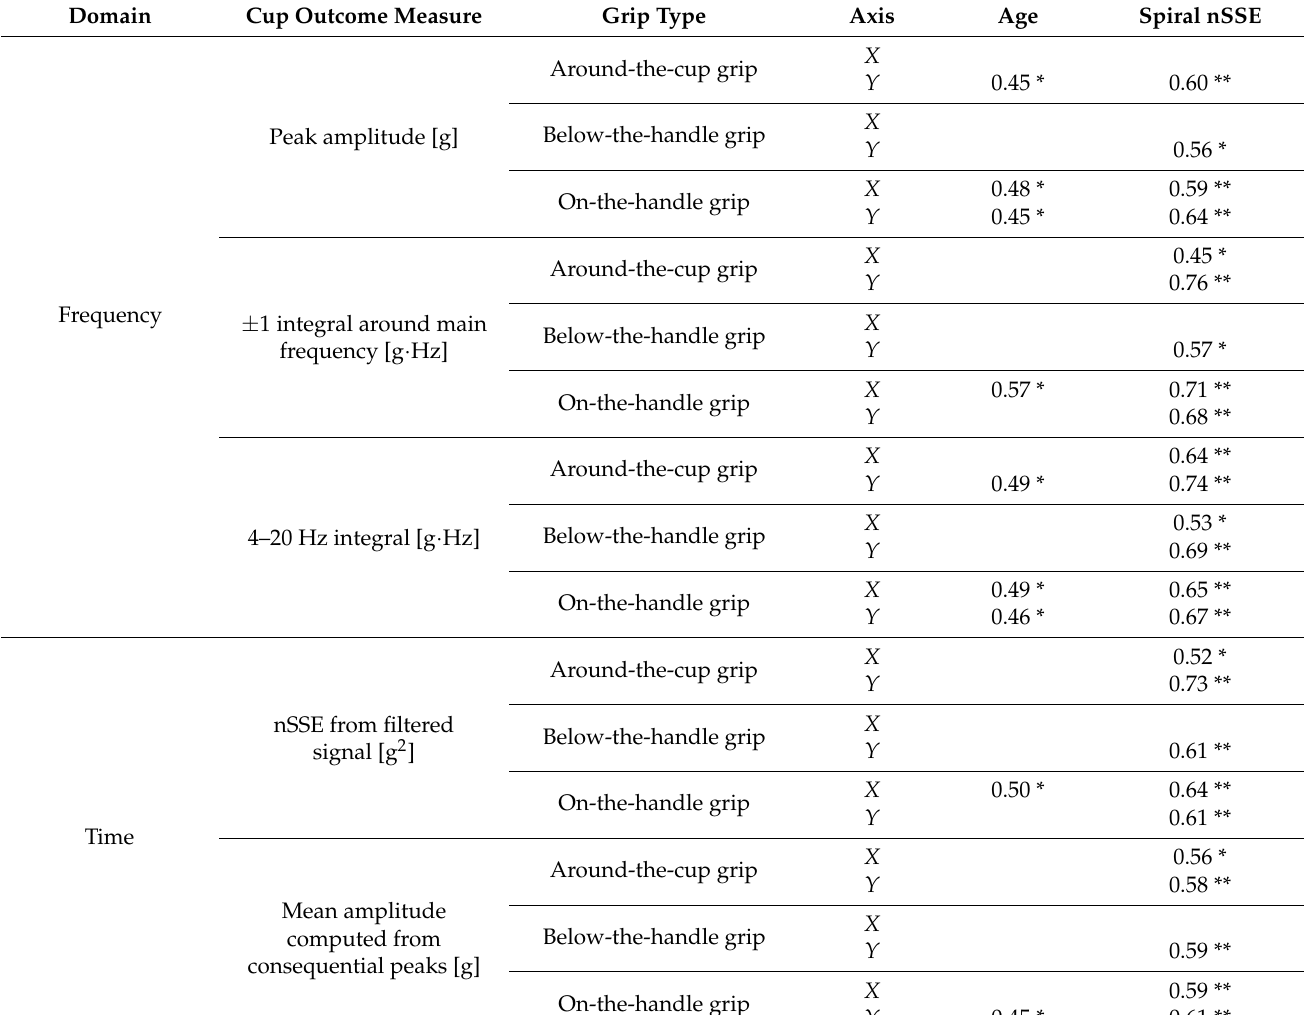
Table 3. Correlation Between Cup Outcome Measures, Age, and Spiral Deviation Outcome Measures, for X and Y Axes and Grip